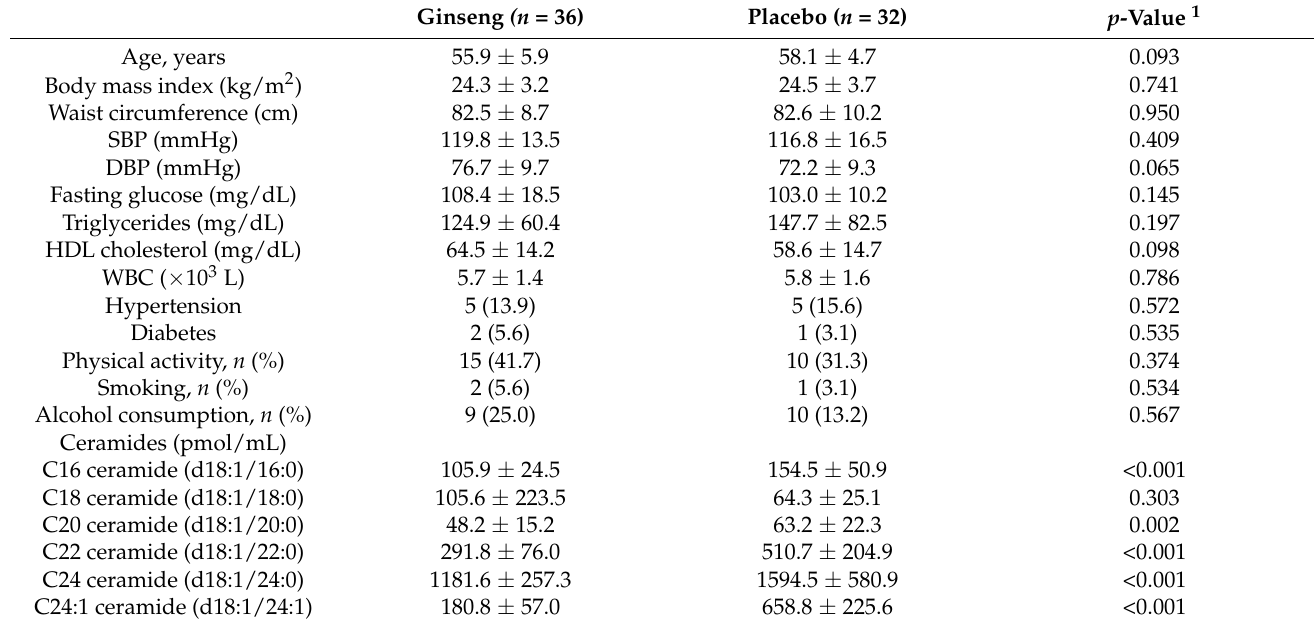
Table 1. Comparison of the baseline characteristics of study participants in the KRG vs. placebo